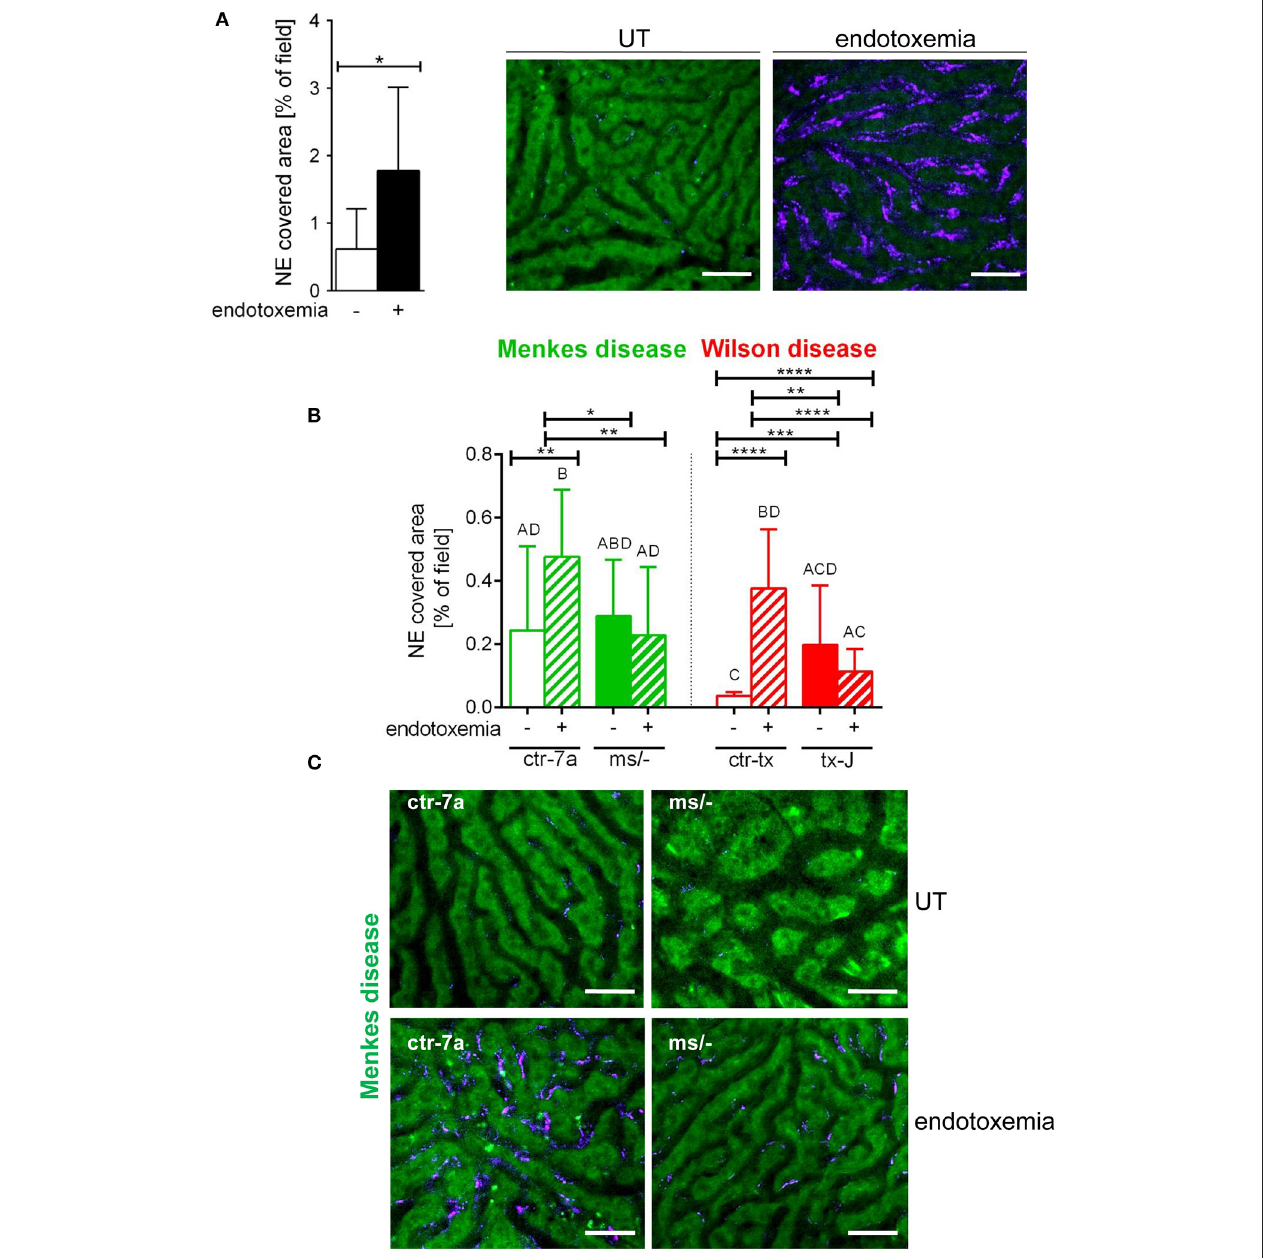
FIGURE 1 | Deposition of neutrophil extracellular traps (NETs) in liver sinusoids during endotoxemia in C57Bl/6J mice (A) and in animals with Wilson (tx-J) and Menkes ( ms / − ) diseases and their respective controls — ctr-tx and ctr-7a (B,C) . NET formation was quantified as the percentage of area covered by neutrophil elastase (NE) in each analyzed field of view (FOV) (mice n = 3/group). Asterisks indicate significant differences using unpaired two-tailed Student’s t test (* P ≤ 0.05, ** P ≤ 0.01, *** P ≤ 0.001, **** P ≤ 0.0001) in (A,B) or one-way ANOVA ( post hoc Bonferroni) test in (B) ; different letters indicate statistically significant differences between groups. Representative pictures of NE deposition in livers of C57Bl/6J mice are presented in (A) and of Menkes disease mice and their littermates in (C) (images of Wilson disease mice and their controls are presented in Supplementary Figure 1 ). On images, autofluorescent hepatocytes (green) can be observed, and between them, sinusoids are seen as black areas. In the latter structures, NE signal is deposited along endothelium (violet). UT, untreated. The scale bar indicates 50 µ m.